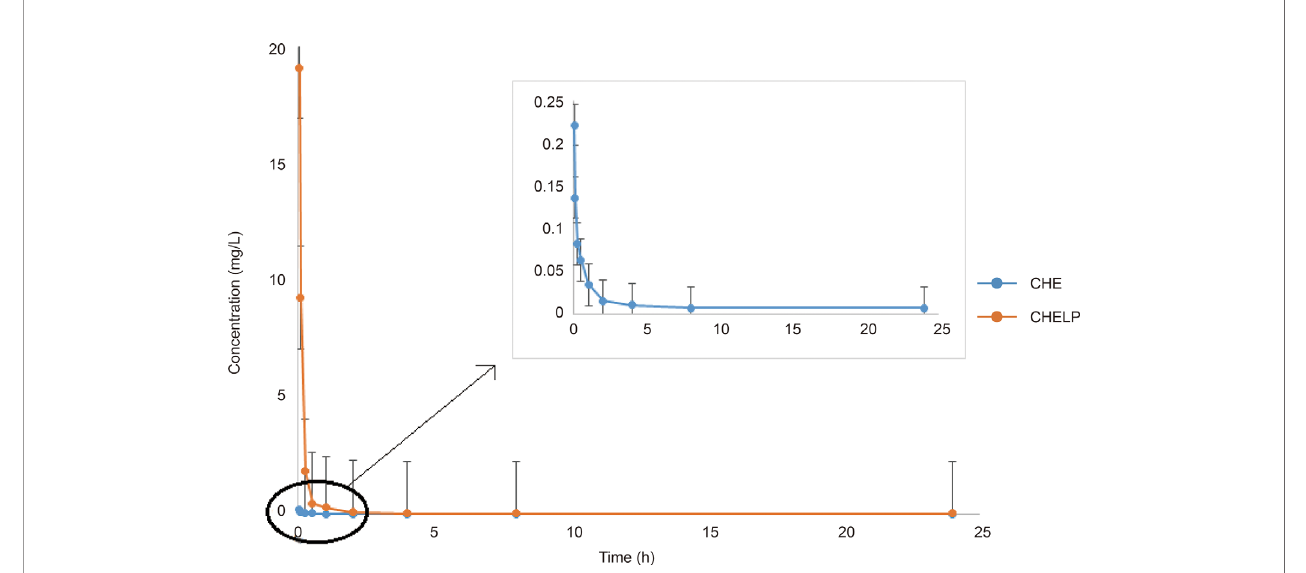
FIGURE 8 | Blood concentration – time curve of CHE and CHELP (n = 3).